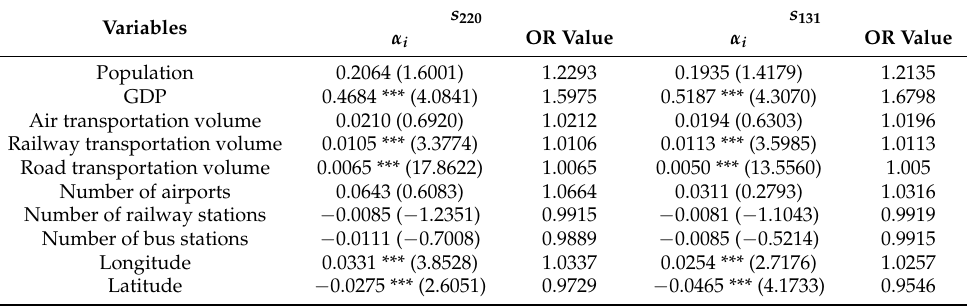
Table 7. Results of negative binomial